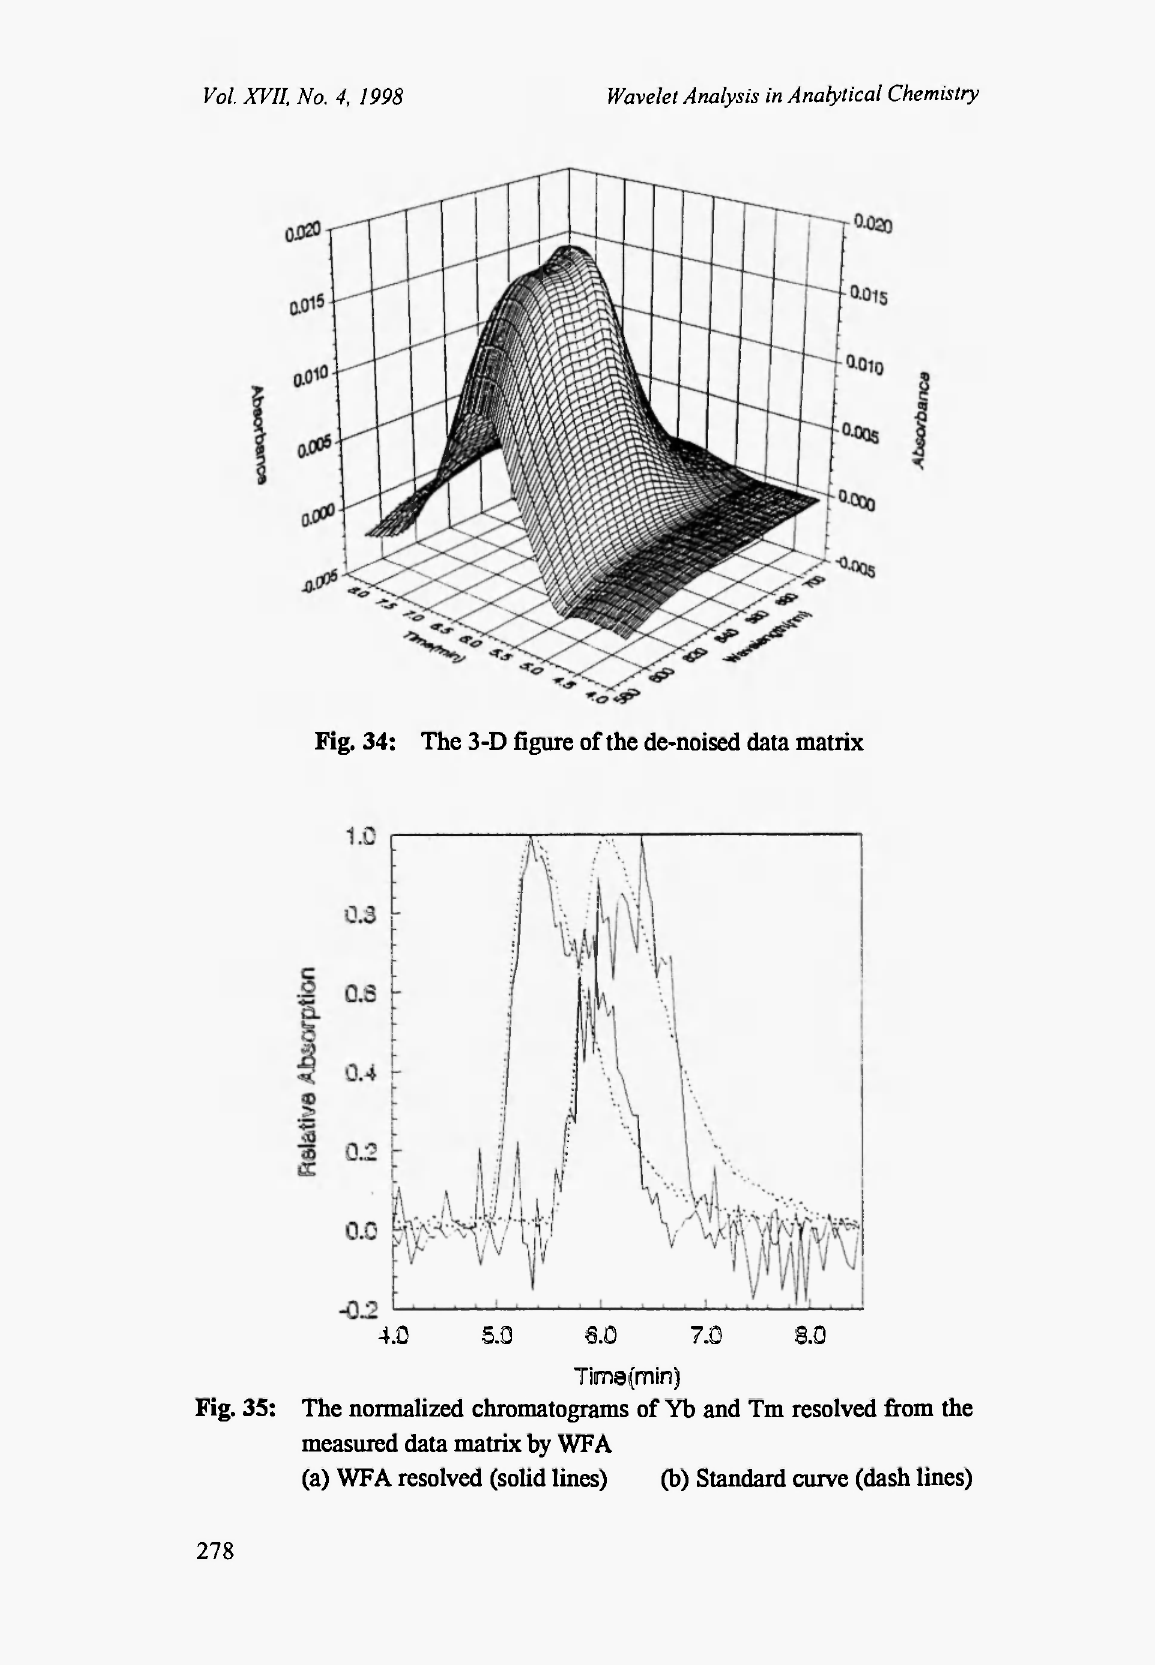
Fig. 35: The normalized chromatograms of Yb and Tm resolved from the measured data matrix by WFA (a) WFA resolved (solid lines) (b) Standard curve (dash